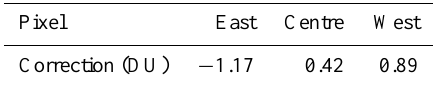
Table A1. The viewing angle as function of pixel for the GDP data set.